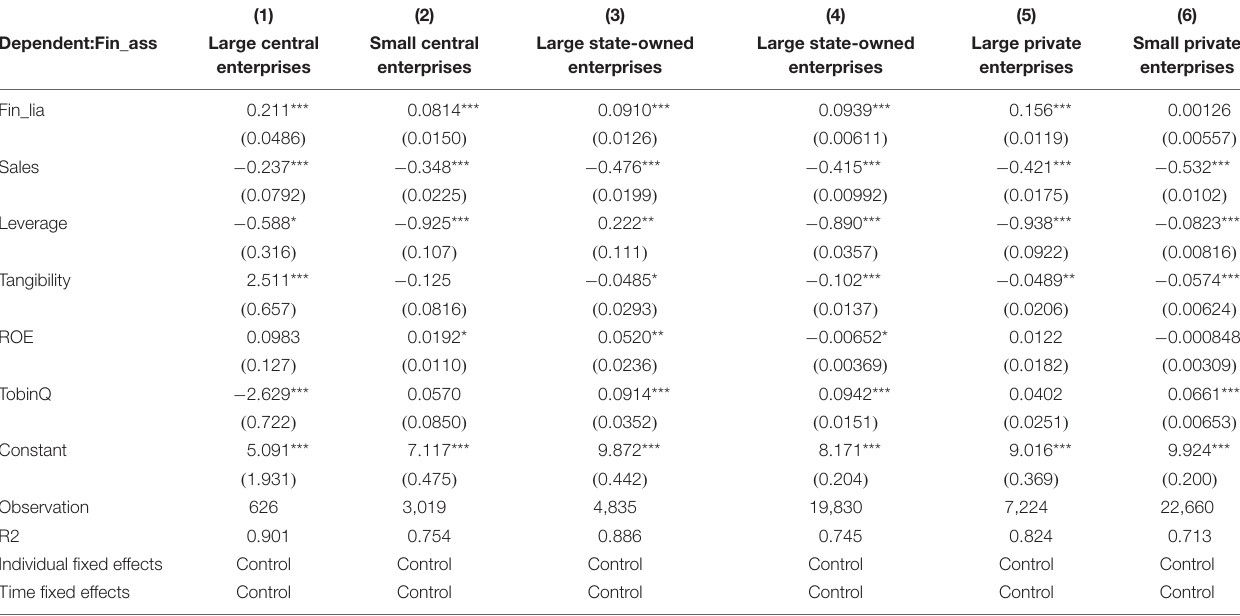
TABLE 3 | “Borrow to Lend” identification model 1: Enterprise heterogeneity.